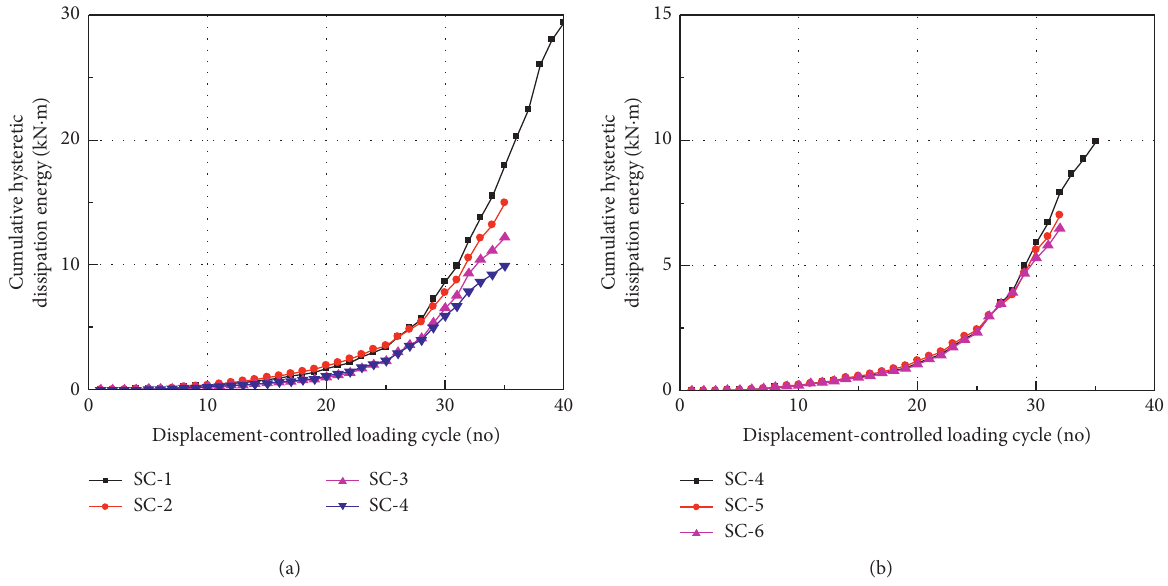
Figure 12: Cumulative hysteretic dissipation energy curves of the specimens. (a) Corrosion-level-induced changes. (b) Stirrup-ratio- induced